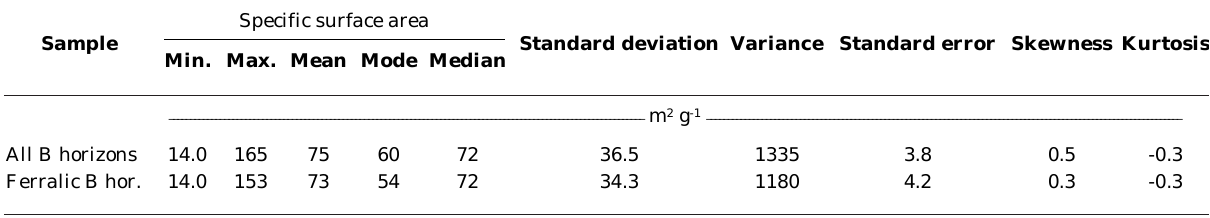
Table 7. Frequency distribution of specific surface